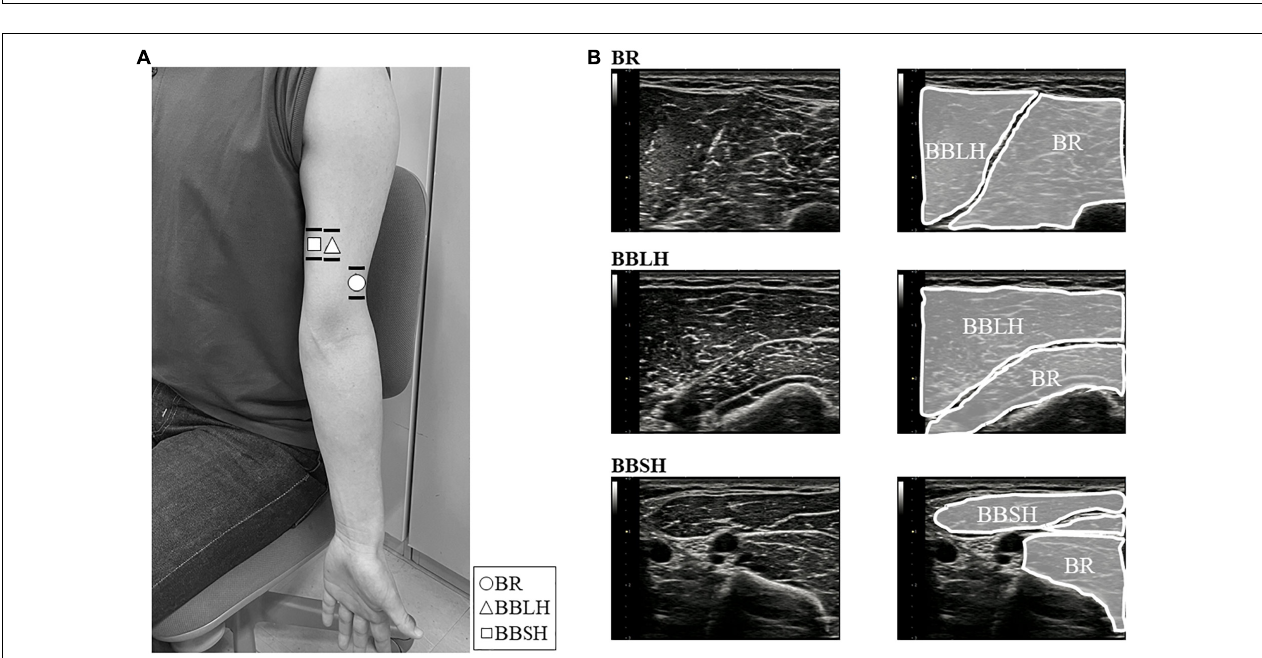
FIGURE 2 | Images of the electrode locations and ultrasonogram for each muscle. (A) The location of surface (lines) and fine-wire (symbols) electrodes of the BR ( (cid:13) ), BBLH ( (cid:52) ), and BBSH ( (cid:3) ). Surface electrodes were placed across the wire insertion of each muscle as shown in the horizontal lines. Fine-wire electrodes were inserted approximately where the symbols were shown. (B) The upper, middle, and lower panels represent the ultrasound images of the BR, BBLH, and BBSH muscles, respectively. BBLH, long head of the biceps brachii muscle; BBSH, short head of the biceps brachii muscle; BR, brachialis muscle.